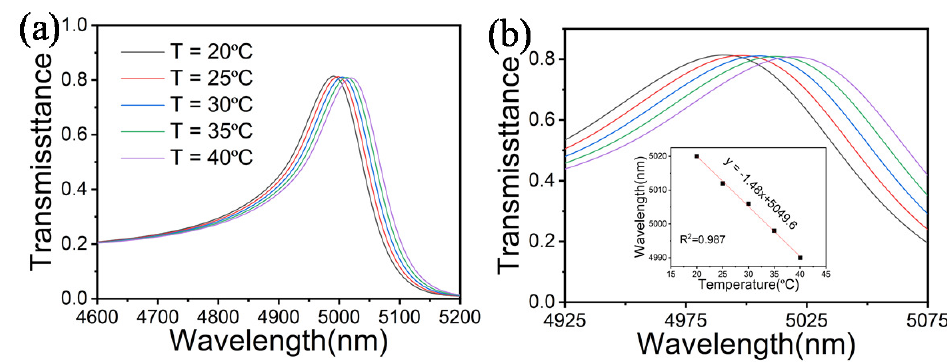
Figure 5. ( a ) Normalized transmittance spectra for NDRR sensor in MIR. ( b ) Enlargement of trans- mission profile in Figure 5a. The insert figure shows that resonance wavelength increases linearly with temperature.